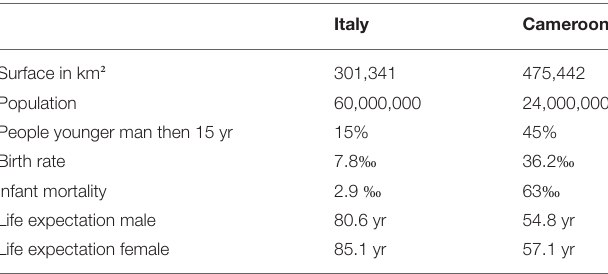
TABLE 1 | Comparative data between Italy and Cameroon.